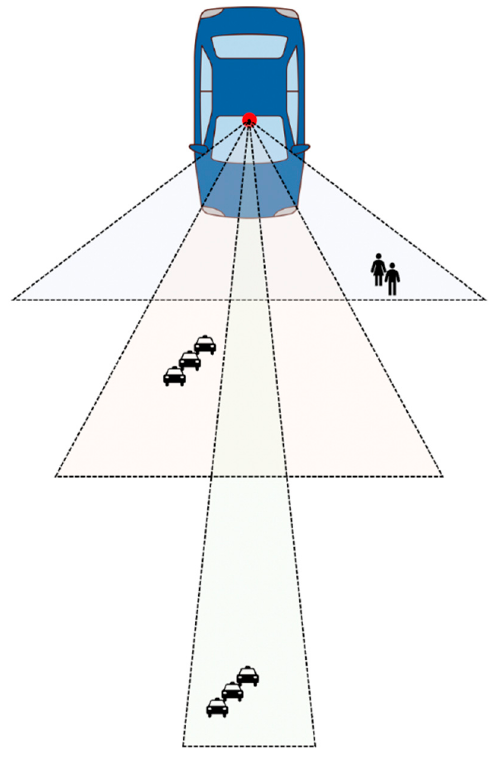
Figure 5. Schematic diagram of variable focus function camera.